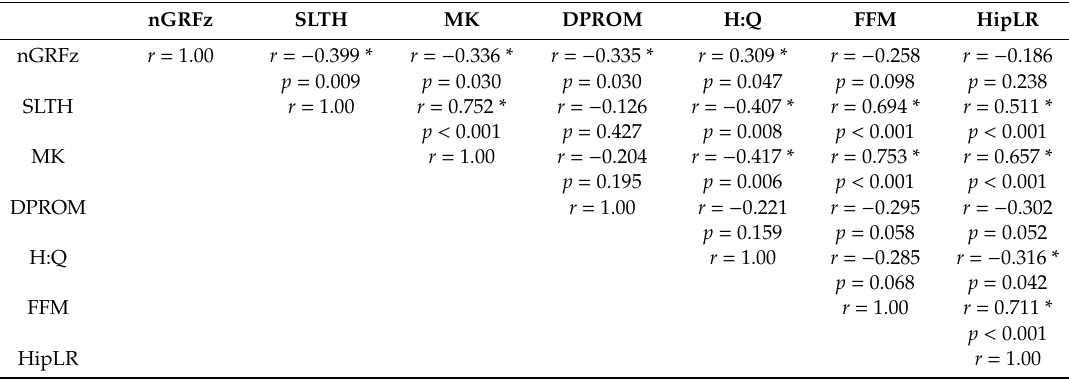
Table 3. Correlation matrix for nGRFz and the independent variables.